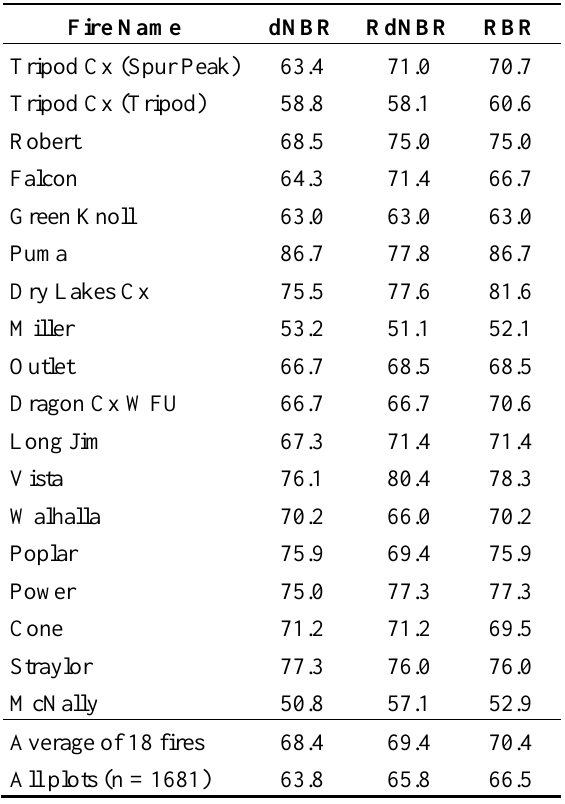
Table A1. Overall classification accuracy when classifying plots into discrete severity classes of unchanged, low, moderate, and high when the dNBR from the equations. The last two rows depict the average classification accuracy among the 18 fires and of all plots analyzed simultaneously, respectively.